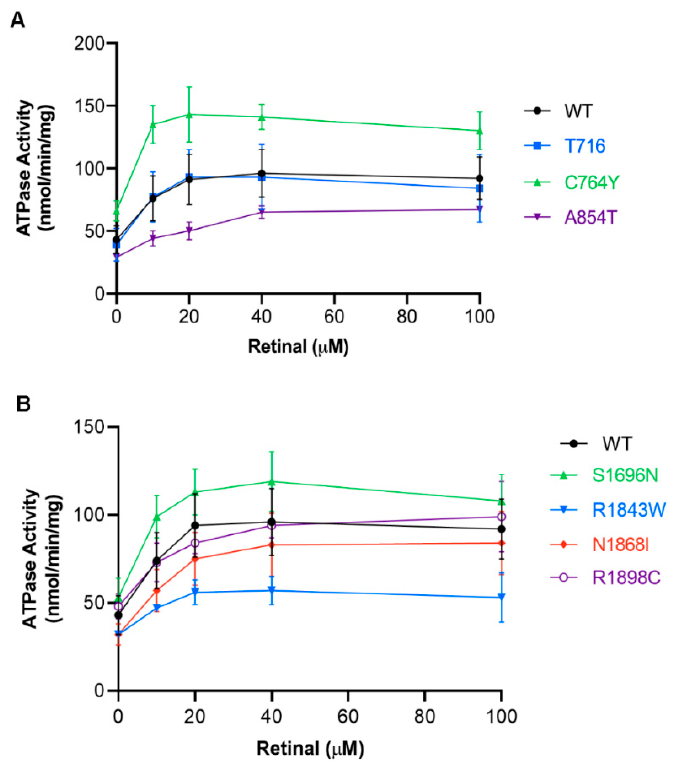
Figure 5. ATPase activity of selected TMD variants as a function of all-trans retinal concentration (Retinal). ( A ) Profiles of TMD1 variants. ( B ) Profiles of TMD2 variants. Specific ATPase activity (nmol of ATP hydrolyzed per minute per milligram of ABCA4) was calculated for the TMD variants. Experiments were performed at concentrations similar to WT ABCA4 and show the mean activity ± SD for n ≥